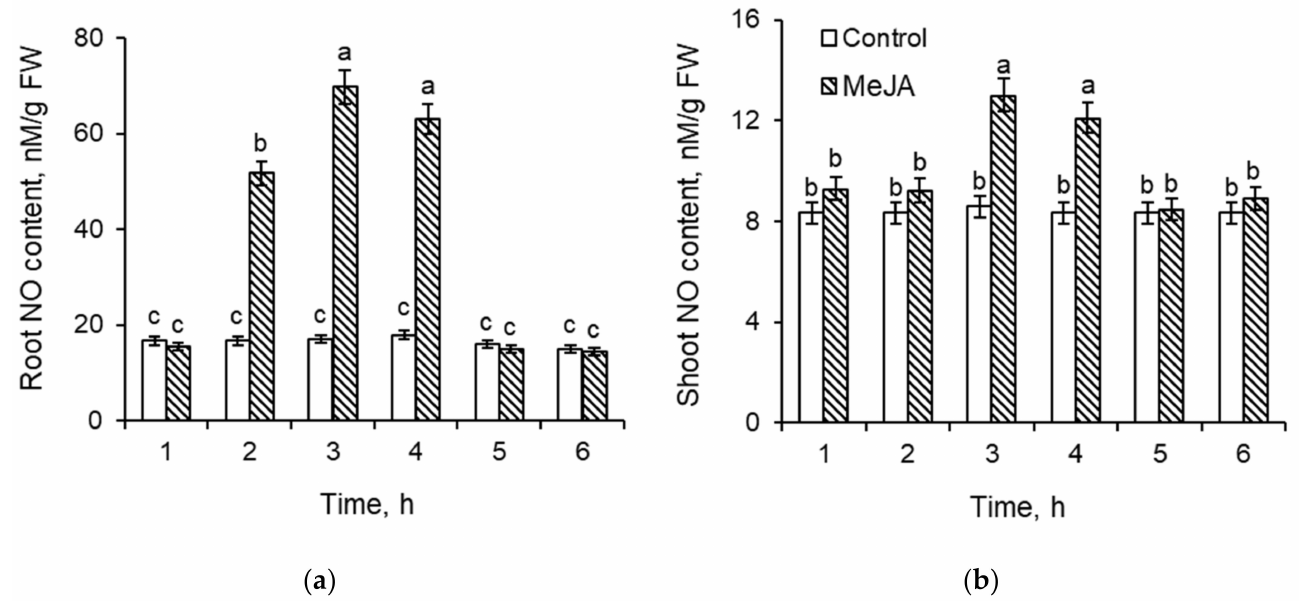
Figure 1. Effect of 10 − 7 M MeJA treatment during 6 h on nitric oxide (NO) generation in roots ( a ) and shoots ( b ) of 5-day-old wheat seedlings. MeJA—methyl jasmonate, FW—fresh weight, g. Data are the mean of three replicates; different letters show significant difference at p ≤ 0.05, and bars indicate ± SE (n =